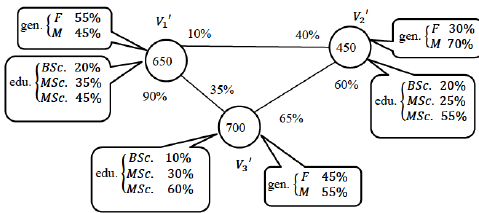
Figure 4: Second summary with three super-nodes and two at- tributes. Attribute values, size of super-nodes and the percentage of vertices, which are in relationship to vertices of the other super- nodes, shown in the summary.